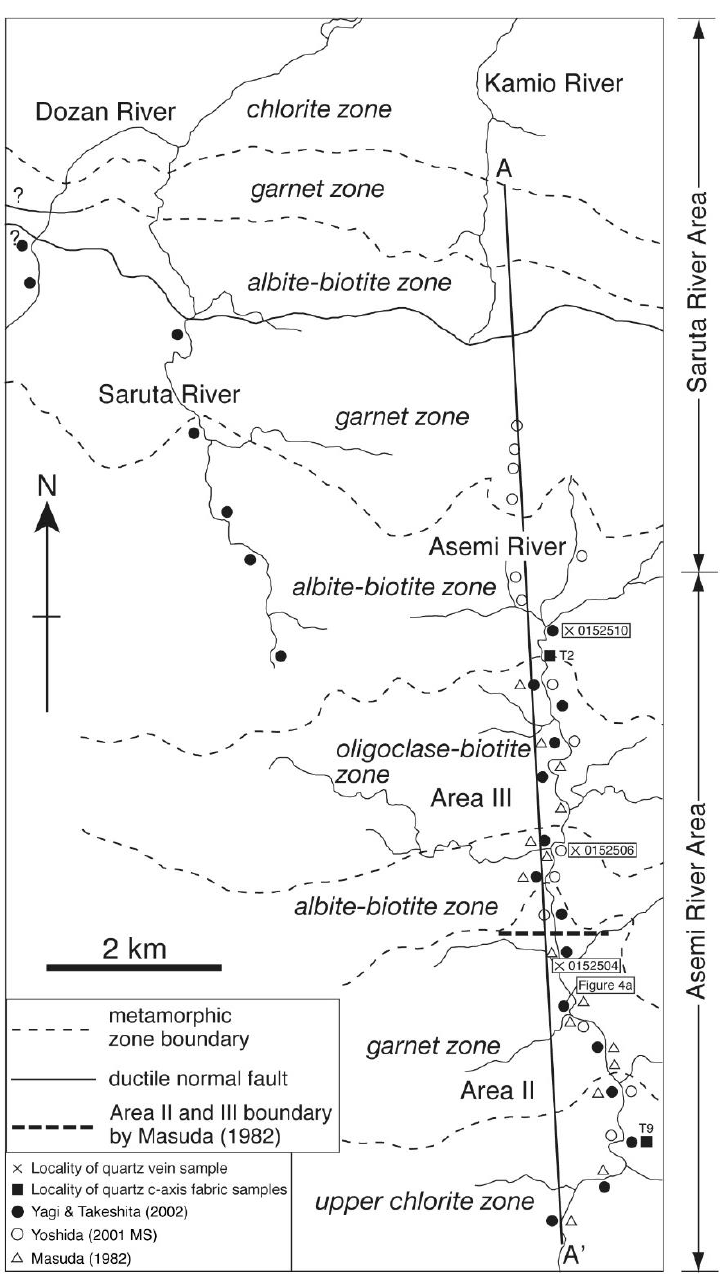
Figure 2. Locality map of quartz schist samples for quartz c -axis fabric, recrystallized quartz grain size, and shape analyses (locality of Figure 2 is shown in Figure 1b). A- A’ is the traverse line on which the data and calculated values (Figures 3, 6, and 7) of each sample are projected. Note that for samples T2 and T9, the quartz c -axis fabrics are shown in Figure 5, but the recrystallized quartz grain size and shape are not analyzed for T2. Readers can also refer to Figure 2 of [20] for the sample localities. For sample numbers analyzed by [46], see their Table 2. For area II and III, see text.